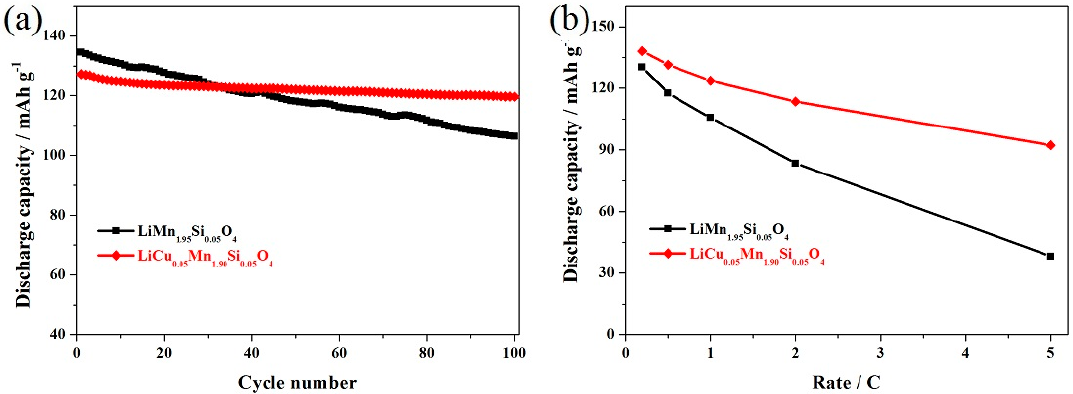
Figure 5. ( a ) Cycling performance and ( b ) rate capacities of the LiCu x Mn 1.95 − x Si 0.05 O 4 (x = 0, 0.05) samples at 55 °C.